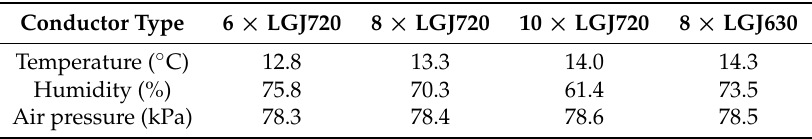
Table 3. Temperature, humidity, and air pressure at test site.